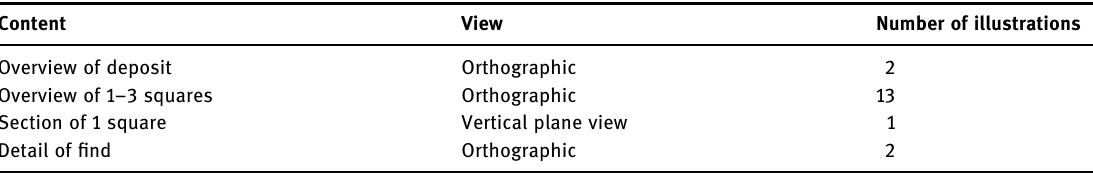
Table 2: The di ff erent uses of the IVS for illustrations in the 2020 student reports Content View Number of illustrations Overview of deposit Orthographic 2 Overview of 1 – 3 squares Section of 1 square Detail of fi